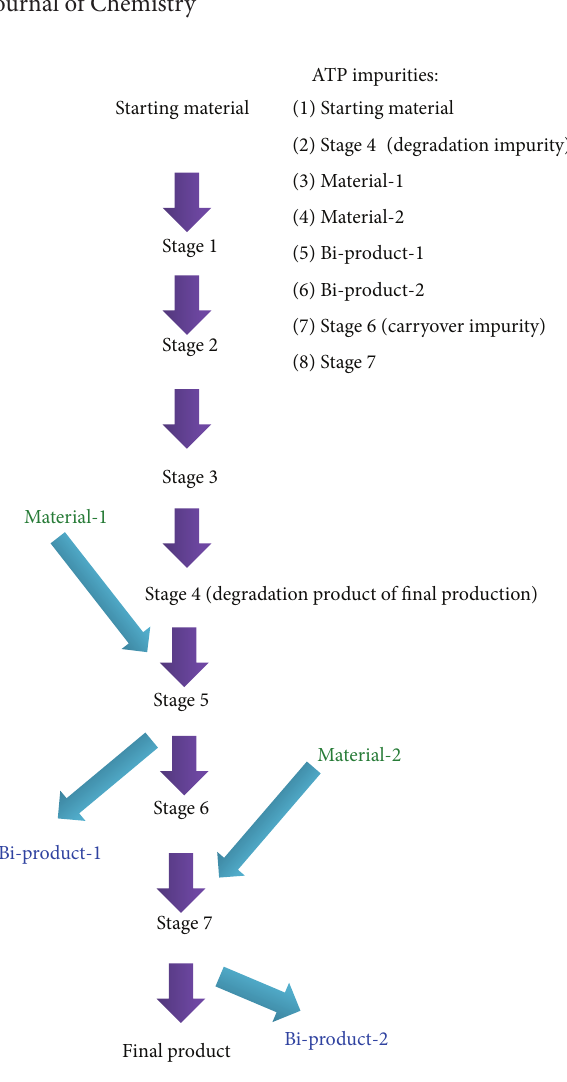
Figure 4: Analytical QbD (AQbD) relation with synthetic develop- ment.